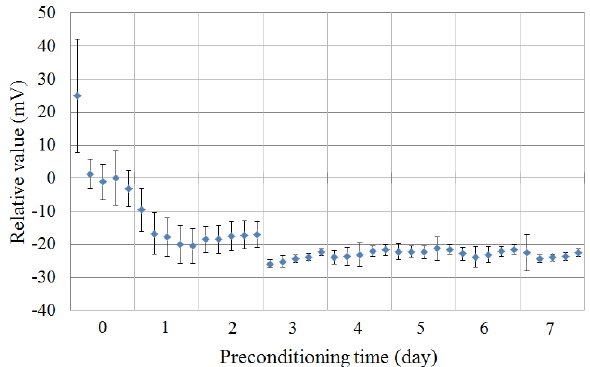
Figure 5. Relationship between the relative value to the saltiness sample (300 mmol/L KCl + 0.3 mmol/L tartaric acid) and the preconditioning time. Data are expressed as mean ± SD (n = 4).